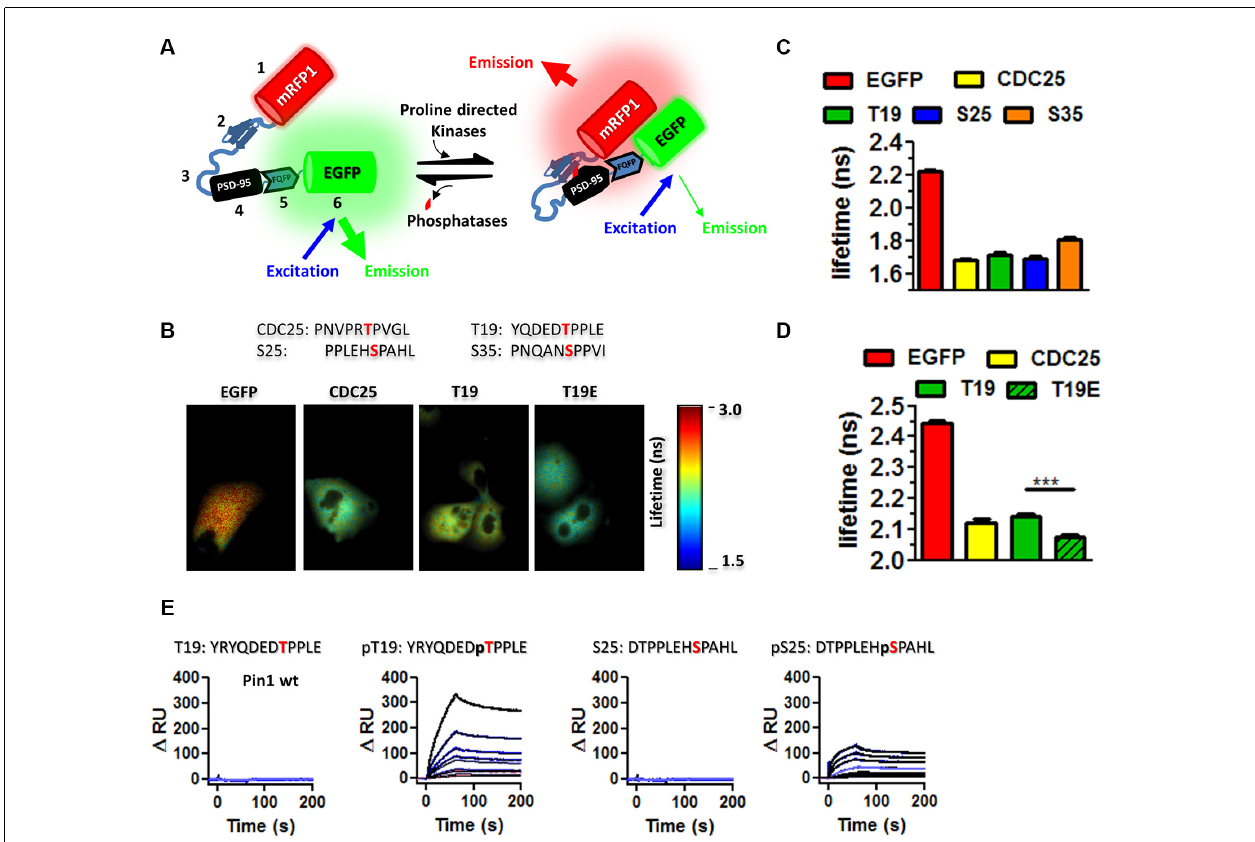
FIGURE 2 | Pin1 WW domain binds the N-terminus domain of PSD-95. (A) EKAR constructs used to screen for interactions with phospho-sequences in PSD-95. EKAR components: 1. mRFP1, 2. Pin1-WW domain, 3. glycine linker, 4. CDC25c substrate peptide or PSD-95 phospho-peptides, 5. ERK docking domain, 6. mEGFP, red diamond represent the addition of phosphate group. (B) EGFP fluorescence lifetime images of COS cells transfected with EGFP, EKAR cyto , EKAR cyto T19, EKAR cytoT19E . The substrate peptide sequence is shown above. (C) The WW domain binds to T19, S25, and S35. Summary plot showing the average EGFP fluorescence lifetime from fixed mounted COS cells EGFP 2.225 ± 0.078 n = 575; CDC25 1.679 ± 0.2001 n = 256; T19 1.715 ± 0.1753; S25 1.689 ± 0.196 ns n = 200; S35 1.808 ± 0.0139. Graphs show the mean ± SEM. (D) Summary plot showing the average EGFP fluorescence lifetime from live COS cell imaging showing equal affinity to CDC25 peptide EGFP 2.444 ± 0.0072 n = 136; CDC25 2.122 ± 0.12 n = 142; T19 2.143 ± 0.082; T19E 2.074 ± 0.078